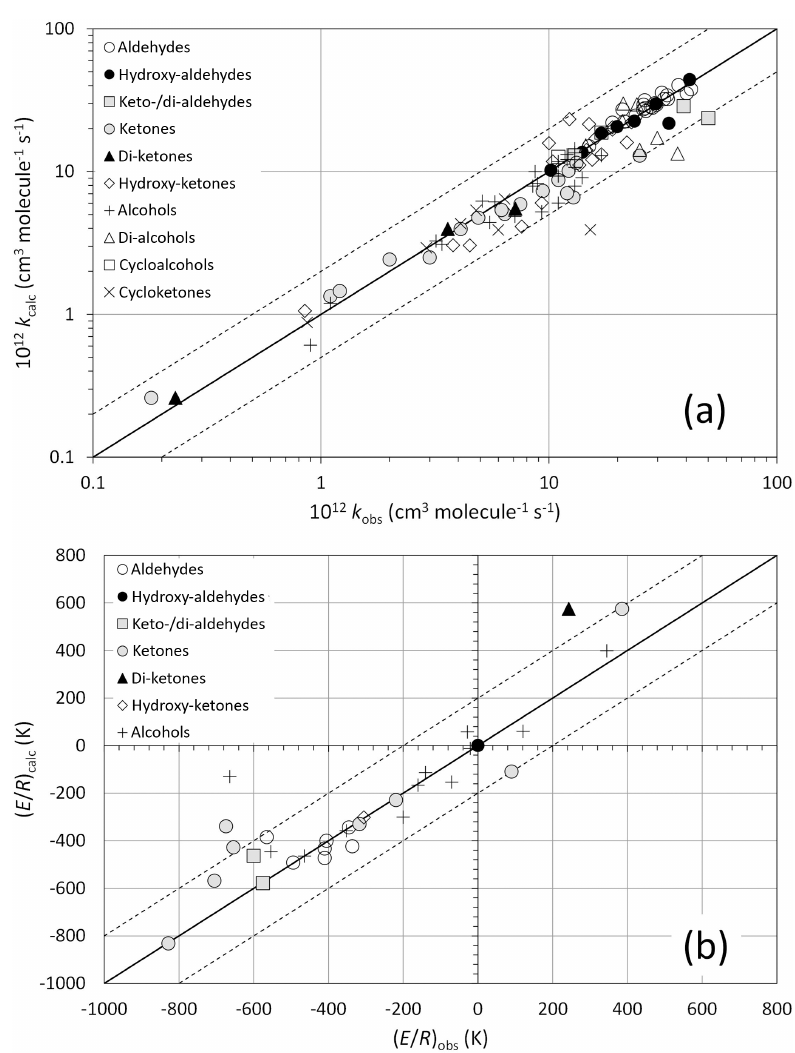
Figure 2. (a) A log–log correlation of k calc and k obs at 298K for saturated organic oxygenates containing carbonyl and hydroxy groups. The broken lines show the factor of 2 range (see Table S1 in the Supplement for identities of outliers). (b) A correlation of the temperature coefficients (E/R) calc and (E/R) obs for the same compound classes. The broken lines show the ± 200K